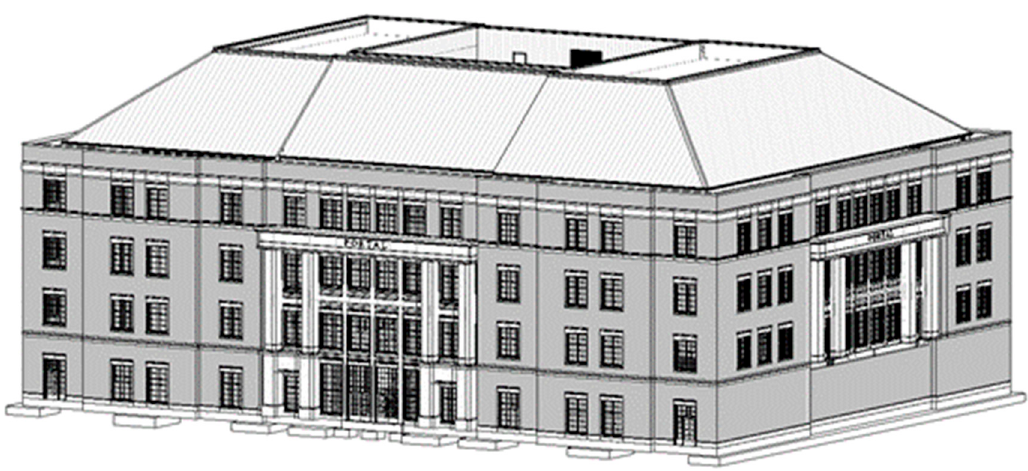
Figure 6. Building information modeling (BIM) model of the PORTAL building.